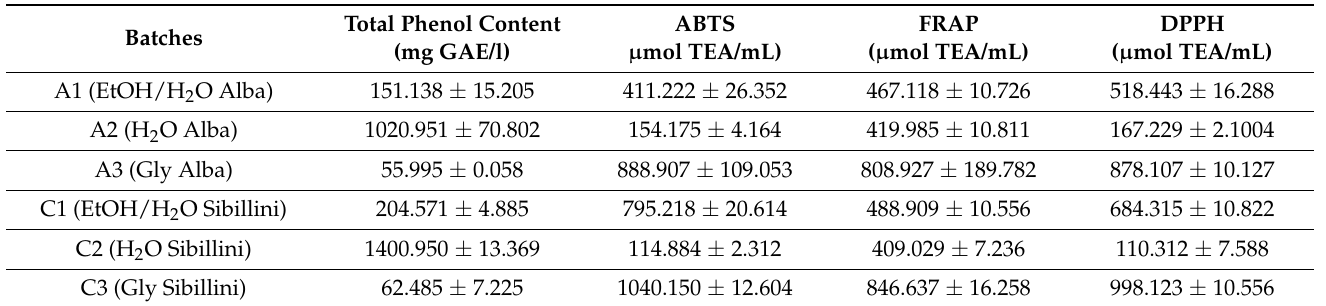
Table 1. Total Phenol Content (TPC) and antioxidant capacity (AC) of different extracts.